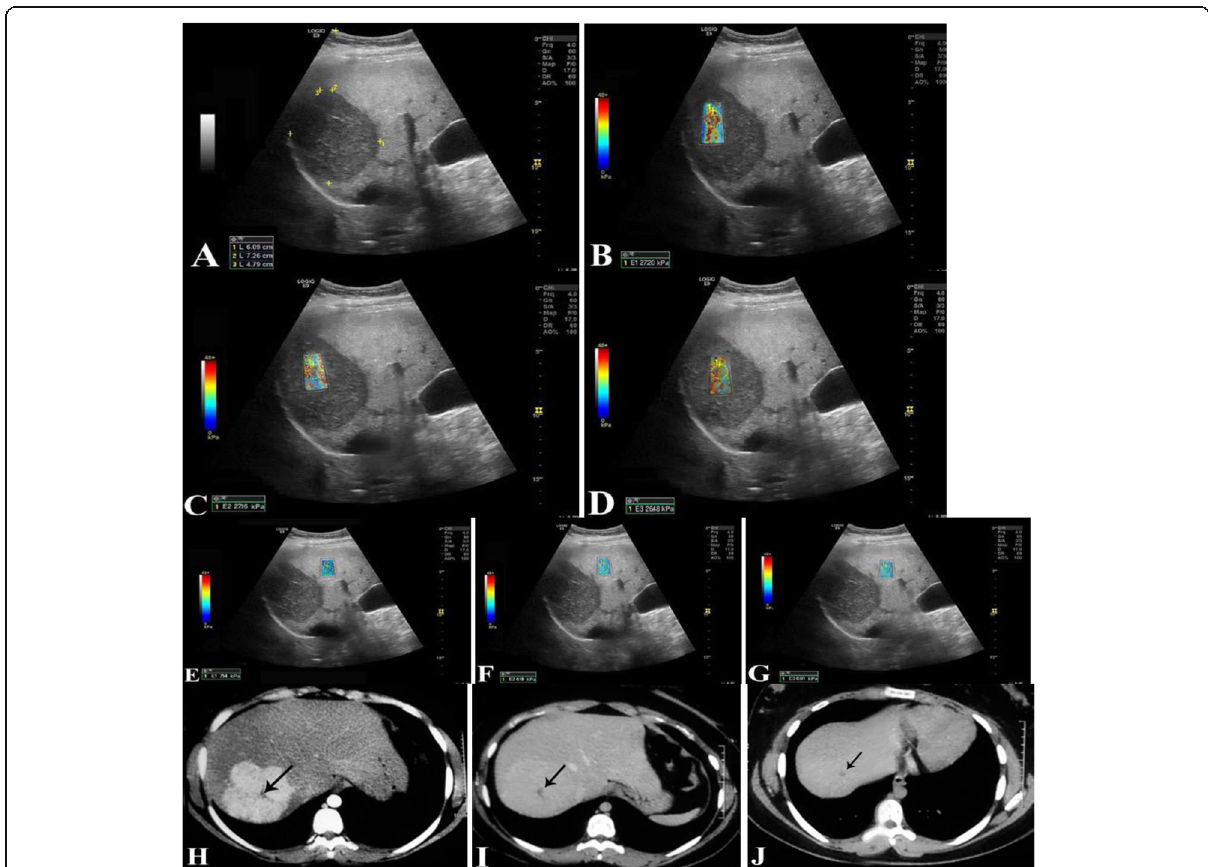
Fig. 2 Nineteen years old female patient presented with incidentally discovered hepatic focal lesion during abdominal ultrasound examination for abdominal pain. Imaging findings: grey scale B-mode ultrasonography ( a ): normal sized liver with a well-defined hypoechoic focal lesion seen in segment VII and VIII measuring 6 × 7.2 cm with 4.7 cm depth from the skin. ϖ Color-coded shear wave sono-elastography: the lesion showed mixed color with red foci ( b , c , d ), while the liver parenchyma showed dark blue color ( e , f , g ). ϖ Shear wave sono-elastography stiffness values of the focal lesion: E1 = 27.20kPa ( b ), E2 = 27.16 kPa ( c ), and E3 = 26.48 kPa ( d ). Calculated average stiffness value of the lesion = 26.94 kPa. ϖ Shear wave sono-elastography stiffness values of the parenchyma: E1 = 7.14 kPa ( e ), E2 = 6.18 kPa ( f ), and E3 = 6.91 kPa ( g ). Calculated average stiffness value of the parenchyma = 6.74 kPa. (cid:129) Lesion/parenchyma stiffness ratio = 3.99. ϖ Axial contrast enhanced triphasic CT study (arterial ( h ), portal ( i ), and delayed ( j ) phases): a well-defined lobulated hypervascular focal lesion is seen in segment VII and VIII with marked enhancement in the late arterial phase and evidence of a typical central scar within the lesion (black arrows). The portal phase demonstrates isoattenuation to the normal liver parenchyma. The delayed phase shows faint enhancement of the central scar. ϖ Pathology: focal nodular hyperplasia. ϖ Diagnosis: focal nodular hyperplasia